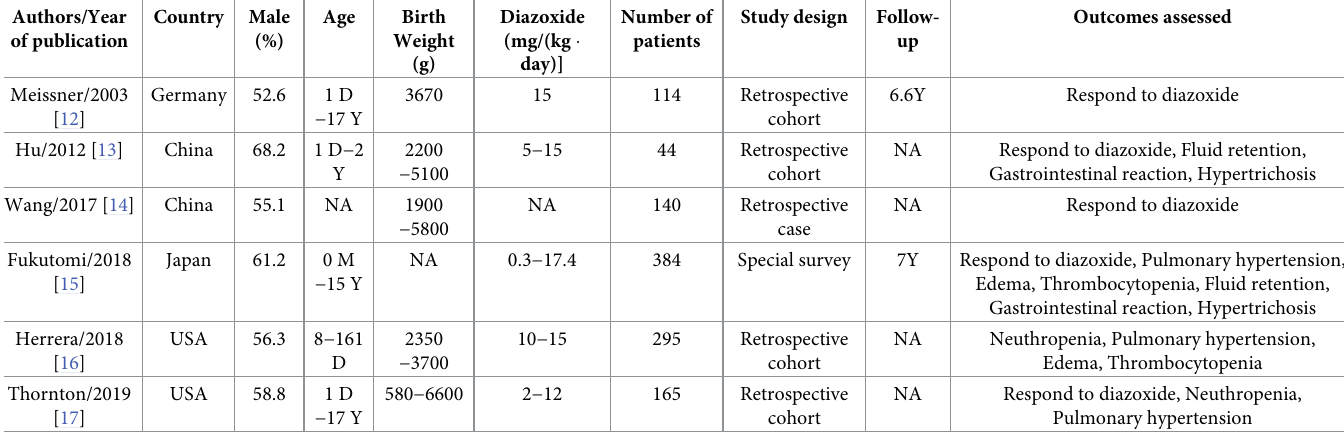
Table 1. Characteristics of the studies included in this meta-analysis.